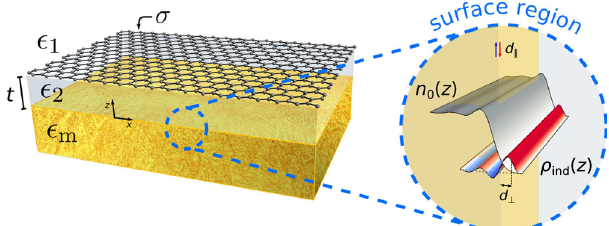
Fig. 1 Schematics of a dielectric – graphene – dielectric – metal (GDM) heterostructure. The graphene – metal separation, t , is controlled by the thickness of the dielectric ( ϵ 2 ) spacer. The close-up (near the metal – spacer interface) shows a pictorial representation of the surface – response functions d ⊥ and d ∥ along with the related the microscopic quantities characterizing the metal surface, namely the equilibrium electronic density, n z ), and the induced charge density, ρ z 0 ( ind (